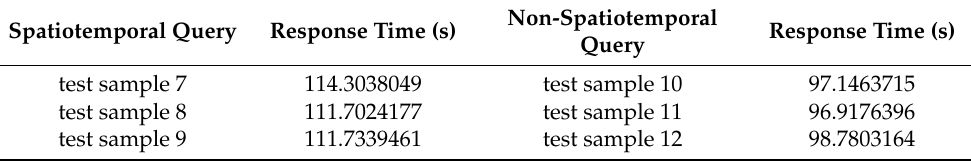
Table 5. stQuery implementation effect of spatiotemporal and non-spatiotemporal queries. Spatiotemporal Query